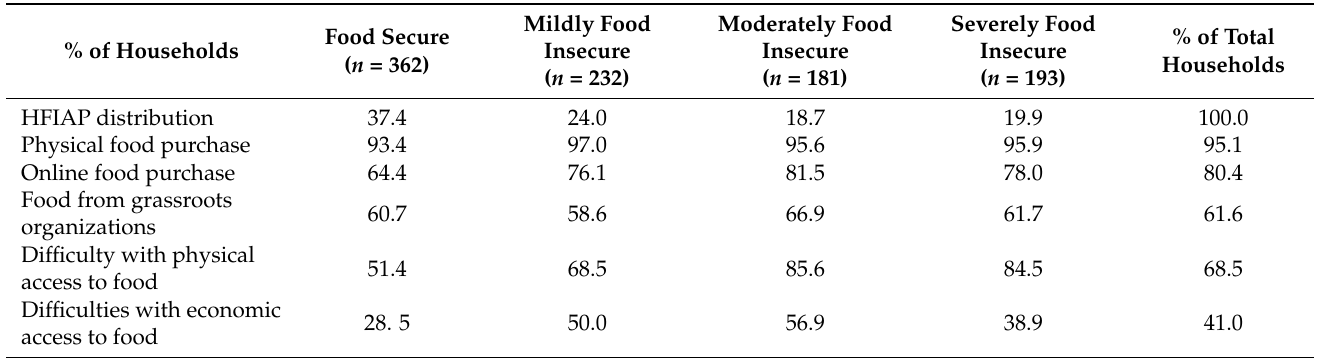
Table 2. Characteristics of food purchasing behaviours by food security